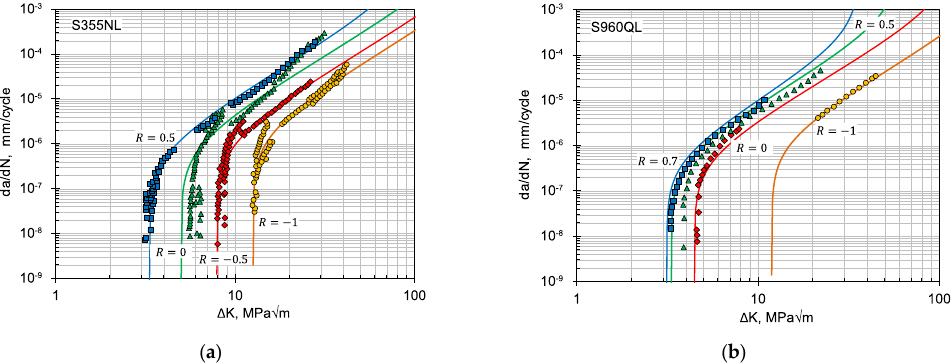
Figure 10. FCG curves for S355NL ( a ) and S960QL ( b ). Symbols: experimental data from [44], curves: analytical fit data from [30]. Symbols and curves of the same color correspond to the same 𝑅 value.